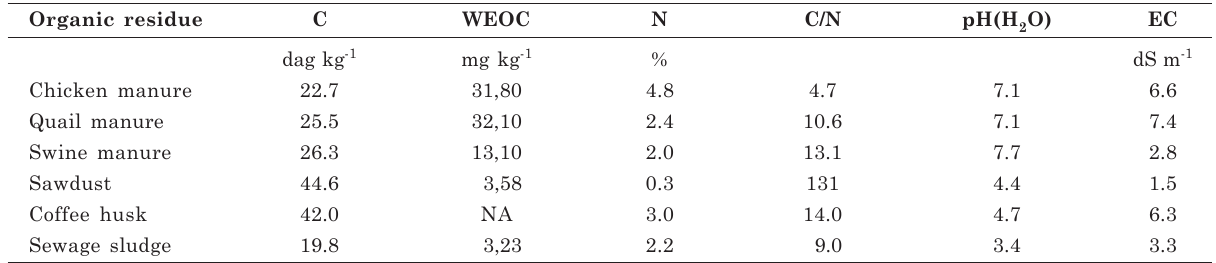
WEOC, water-extractable organic carbon; C/N, C/N ratio; EC, electrolytic conductivity; NA, not analyzed. Source: data compiled by Pinheiro et al.